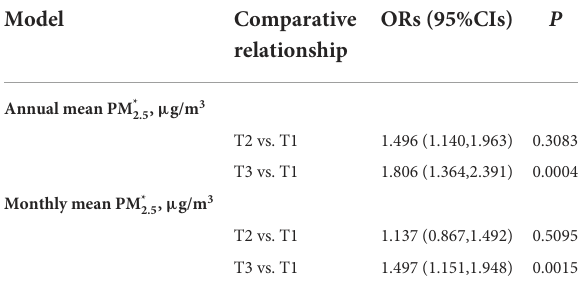
TABLE 4 Logistic regression analysis of PM 2.5 exposure level with allergic rhinitis risk.